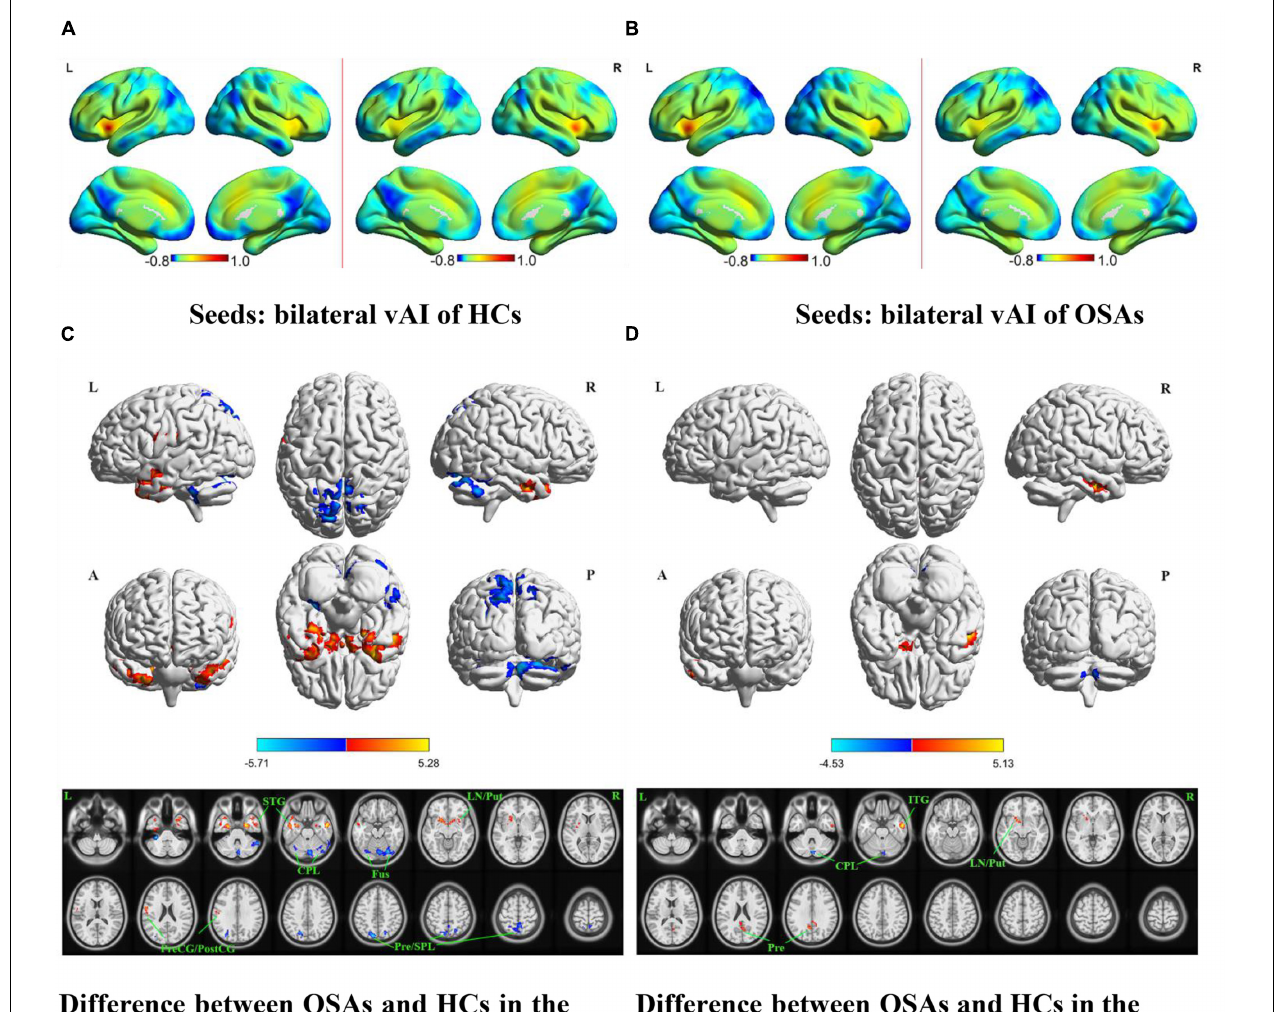
FIGURE 2 | The spatial distribution of the FC maps of the bilateral vAI in the two groups and between-group comparisons of the rs-FC of the bilateral vAI. The FC patterns of the bilateral vAI in the HC and OSA groups are shown in (A,B) , respectively. Color bars indicate z -values; warmer colors indicate higher z -values relative to the whole-brain average, while colder colors indicate lower z -values. (C) Denotes the altered FC based on the left vAI seed in OSAs relative to HCs. (D) Denotes the altered FC based on the right vAI seed in OSAs relative to HCs (voxel-level P < 0.001, AlphaSim corrected). Color bars indicate t-scores; warm colors indicate areas where the FC value in OSAs is greater than that in HCs, while cold colors indicate the opposite. HCs, healthy controls; OSAs, obstructive sleep apnea patients; vAI, ventral anterior insula; FC, functional connectivity; STG, superior temporal gyrus; ITG, inferior temporal gyrus; LN, lentiform nucleus; Put, putamen; PreCG, precentral gyrus; PostCG, postcentral gyrus; CPL, cerebellum posterior lobe; Fus, fusiform gyrus; SPL, superior parietal lobule; Pre, precuneus; L, left; R, right; A, anterior; P,